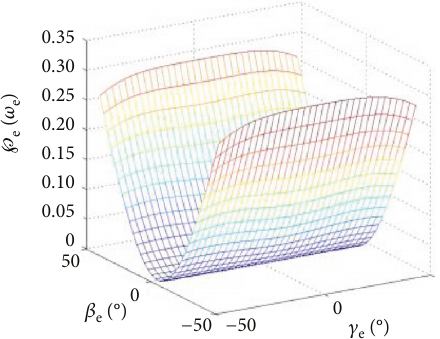
Figure 3: Index of the kinematic decoupling performance of output angle velocity when the input velocity has the X e axis and Y e